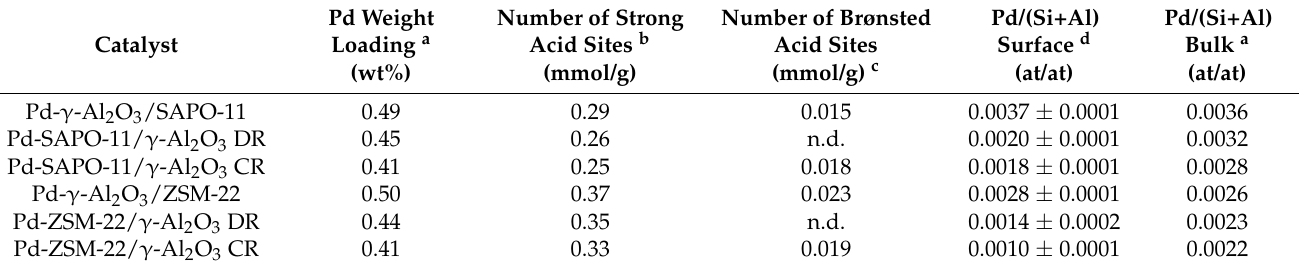
Table 1. Results of catalyst characterization: Pd weight loading, number of acid sites and Pd/(Si+Al) ratios.